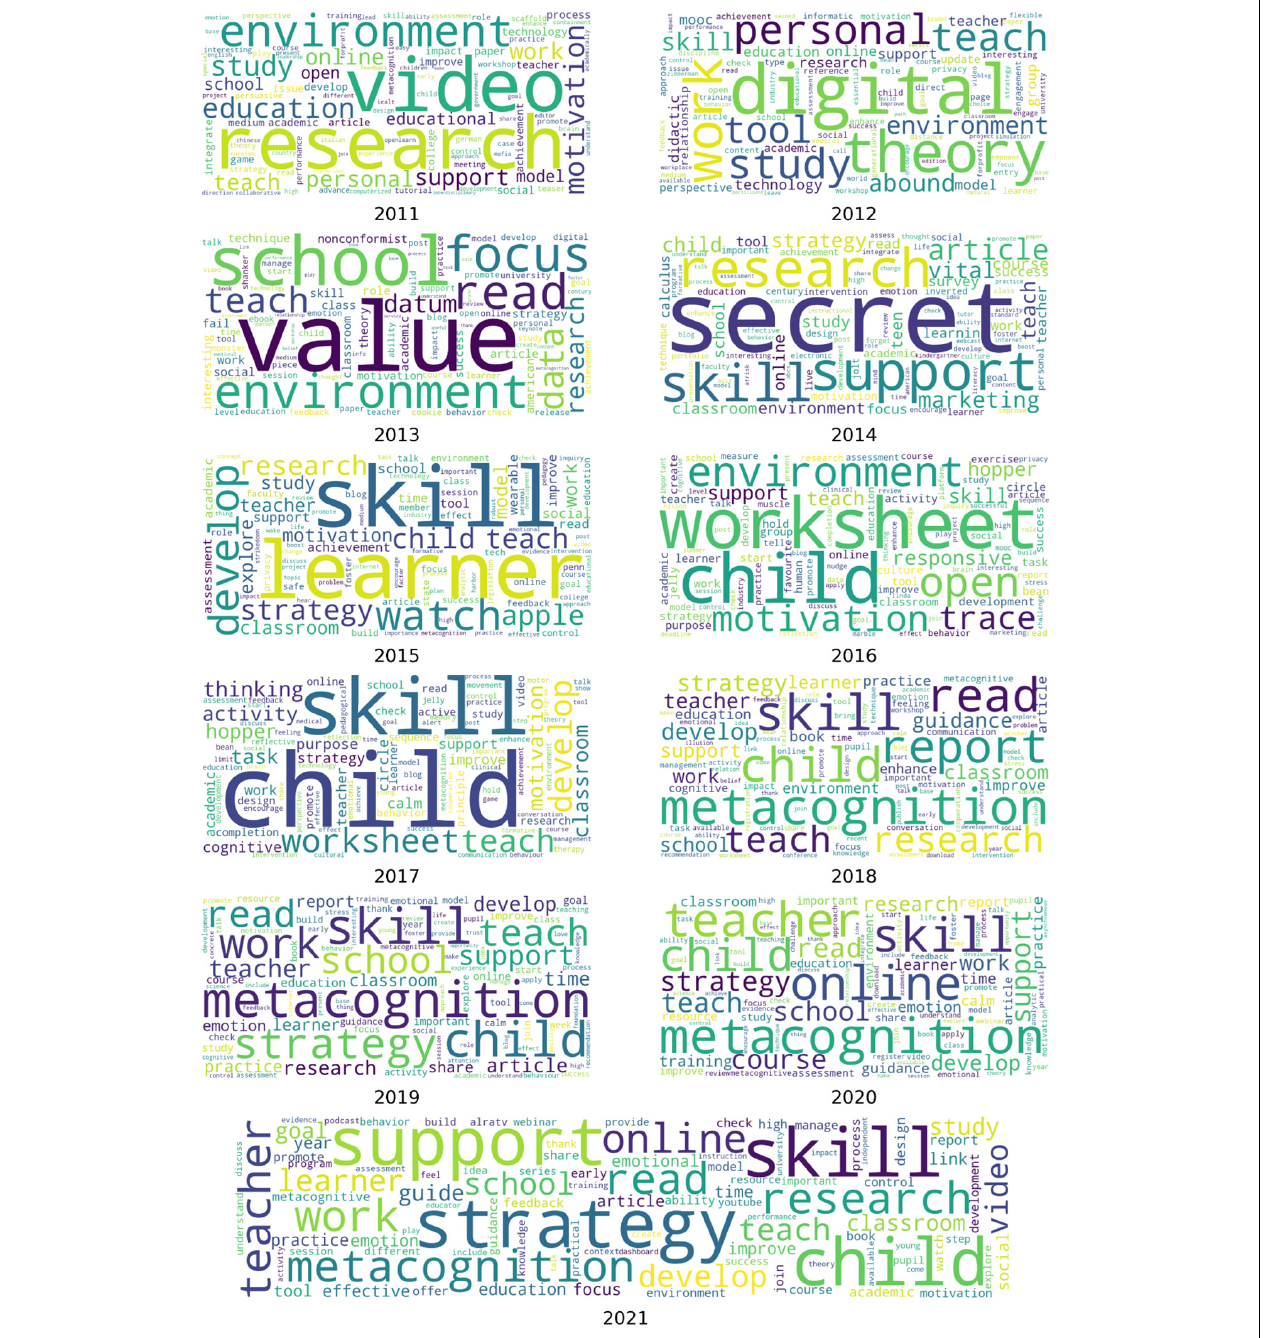
FIGURE 3 | Word cloud of the most common words in the corpus of 54,070 tweets on SRL discussions divided by year (the larger the word print, the more frequent it